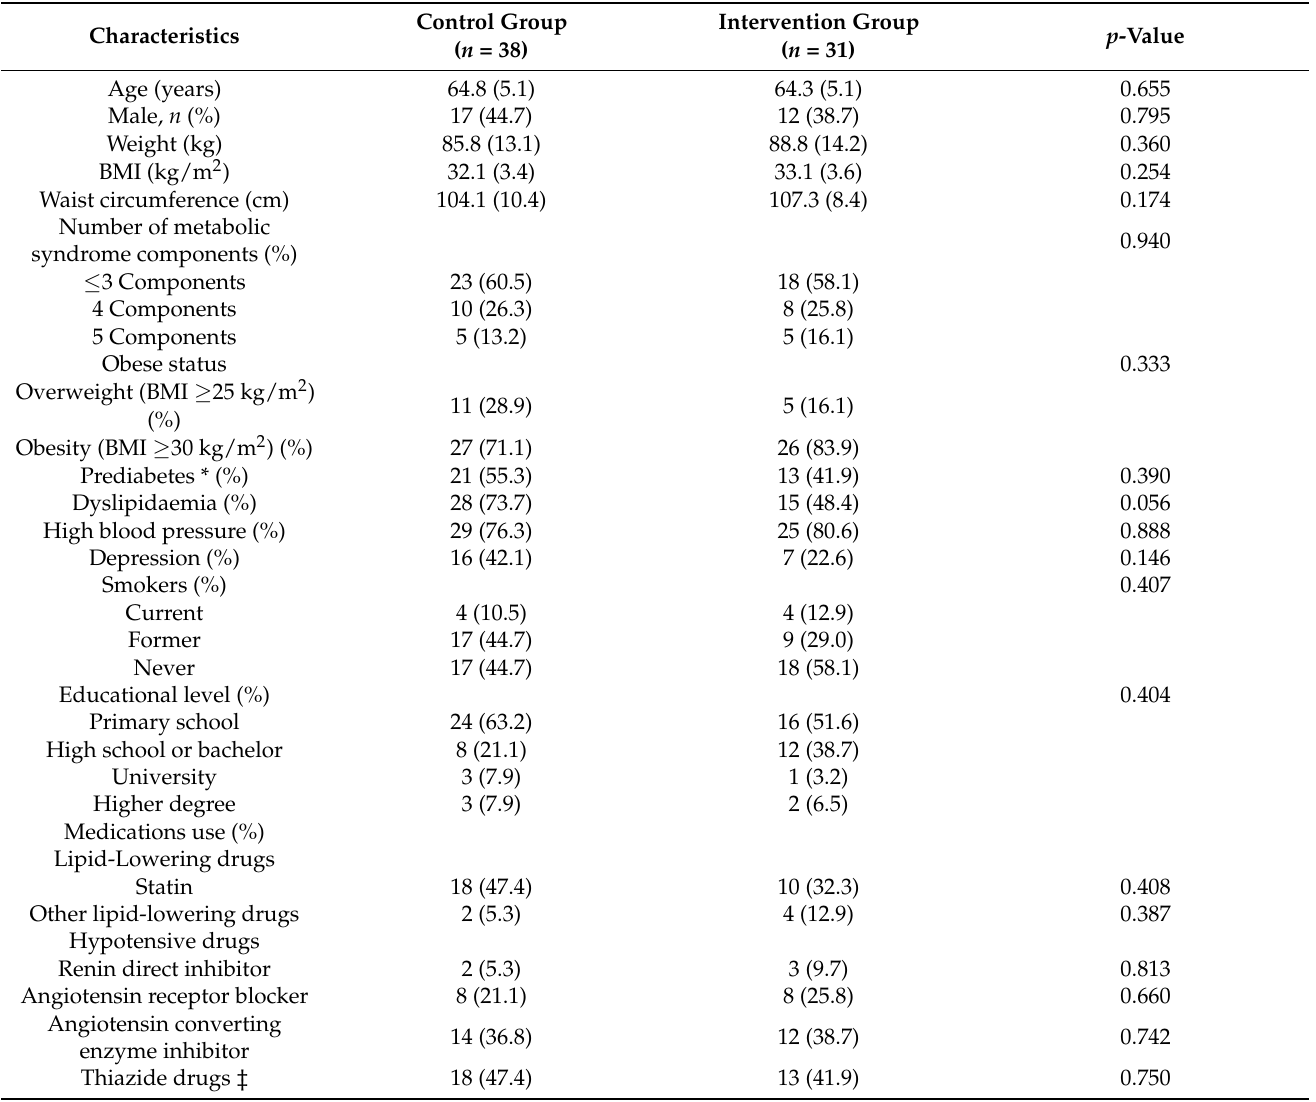
Table 1. Baseline characteristics of the subjects at randomisation before the start of the